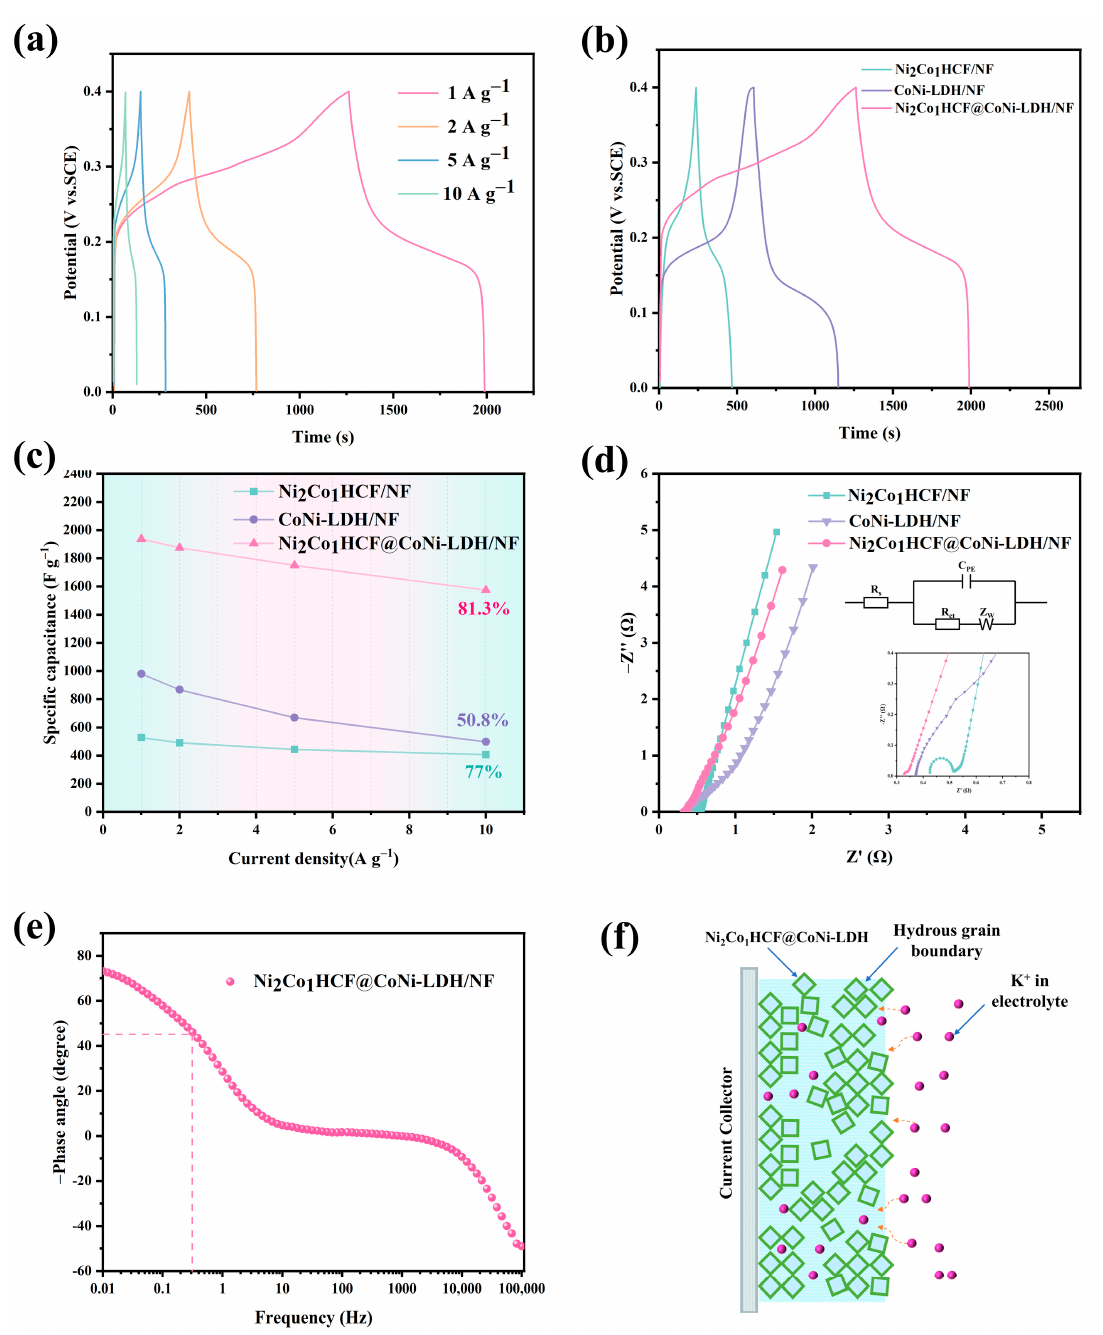
Figure 5. ( a ) GCD curves of the Ni 2 Co 1 HCF@CoNi-LDH/NF composites at different current densities; ( b ) comparison of the GCD curves at a current density of 1 A · g − 1 ; ( c ) comparison of the specific capacitance variations at different current densities of the materials; ( d ) comparison of the Nyquist plots; ( e ) Bode diagram of the composite materials; ( f ) schematic diagram of the electrode material diffusion process.